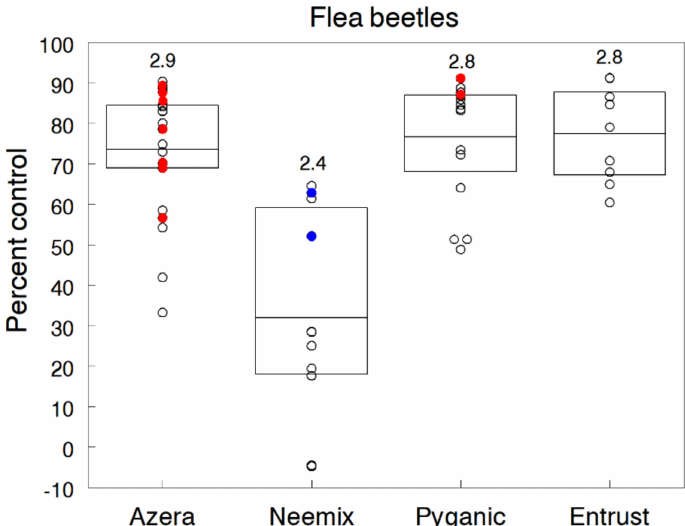
Figure 4. Percent control of flea beetles with weekly applications of Azera, Neemix, PyGanic and Entrust relative to the untreated control. Mean data are given for 11 trials on eggplant. Box-whisker plots show the 25% and 75% percentile range of percent control data and the horizontal line in each box is the overall mean control e ffi cacy. Number above each plot indicates the average number of weekly applications. Application rates of Azera, Neemix, PyGanic and Entrust were 2.34 L / h, 1169 mL / h, 2.34 L / h and 71.2 g a.i. / h respectively, except for individual trial data in blue and red indicating lower and higher rates, respectively. Neemix provided significantly lower control than the other